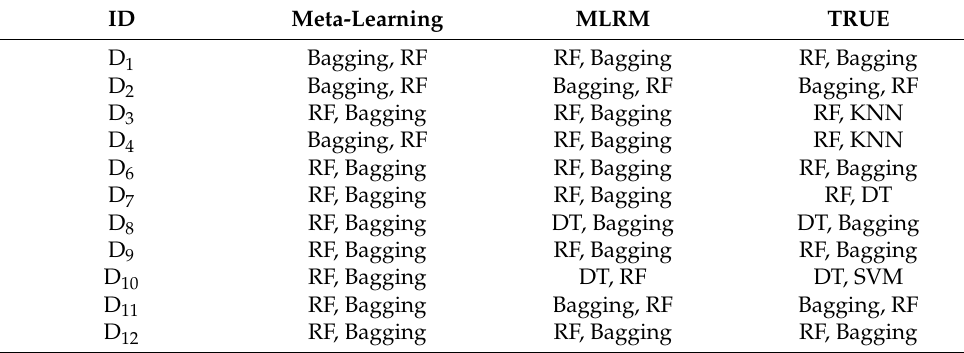
Table 8. Recommendation results between MLRM and meta-learning in quinaries.